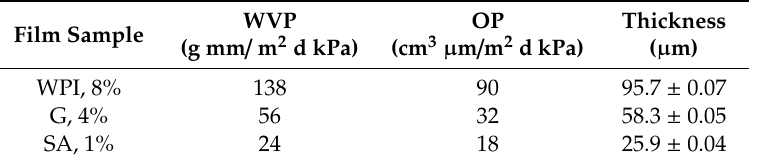
Table 5. Water vapour permeability and oxygen permeability of single layer films [16]